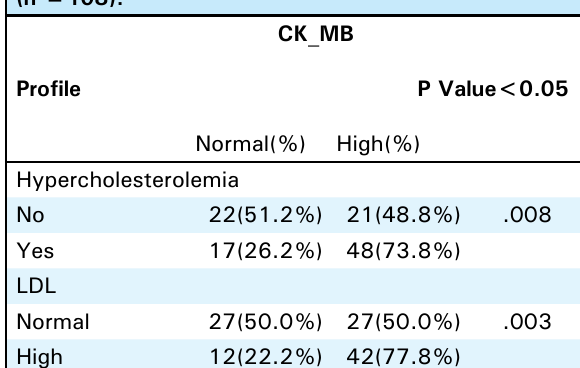
table 3. Correlation of clinical profile with